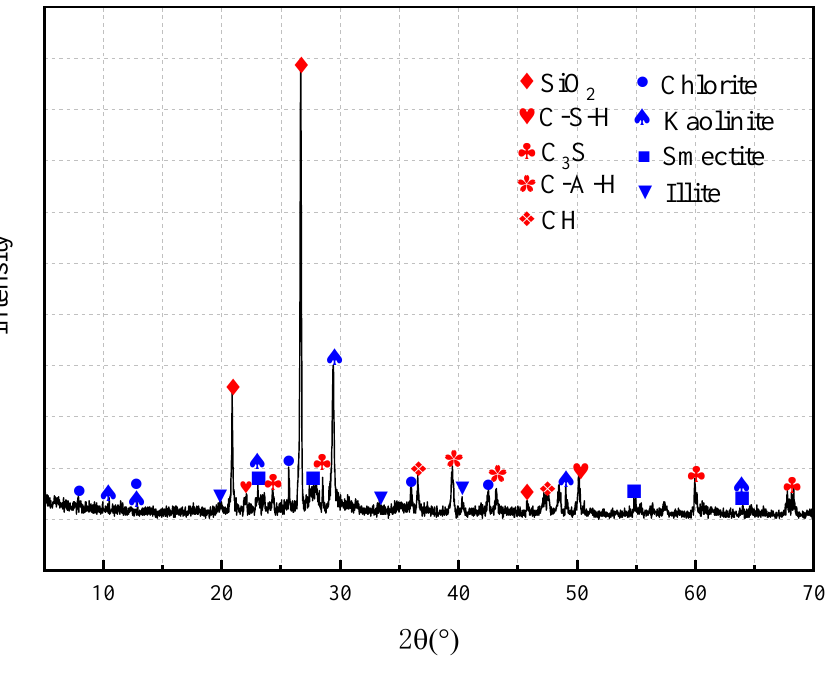
Figure 11. XRD of the test specimen.